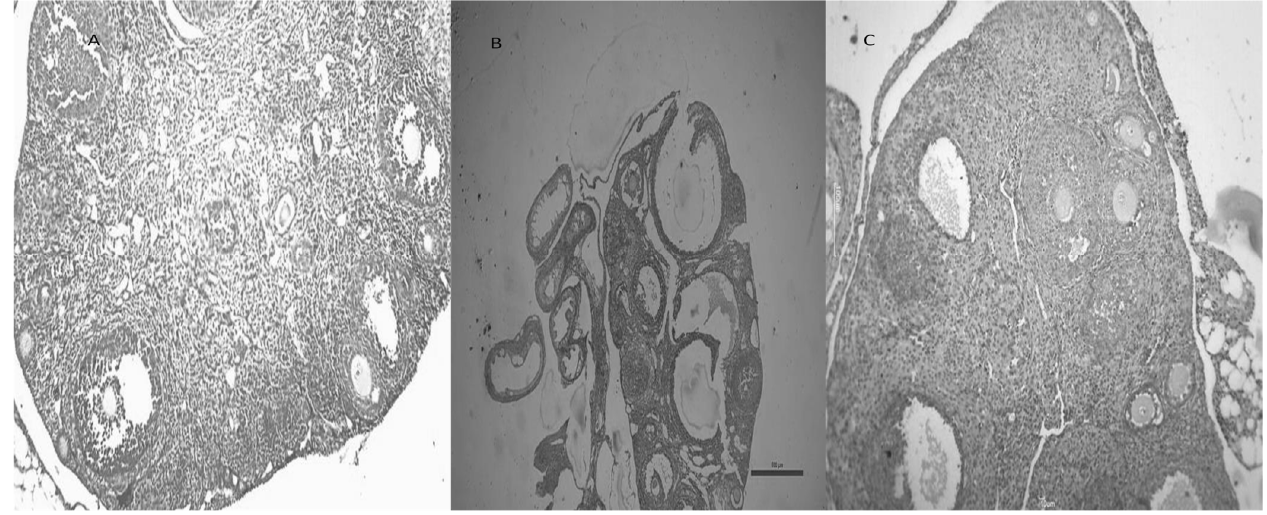
Figure 7. ( A – C ) Histopathological photomicrographs of each experimental group’s ovaries (H&E, magnification ×10): ( A ) control, ( B ) LETZ, and ( C ) LETZ with CGA.